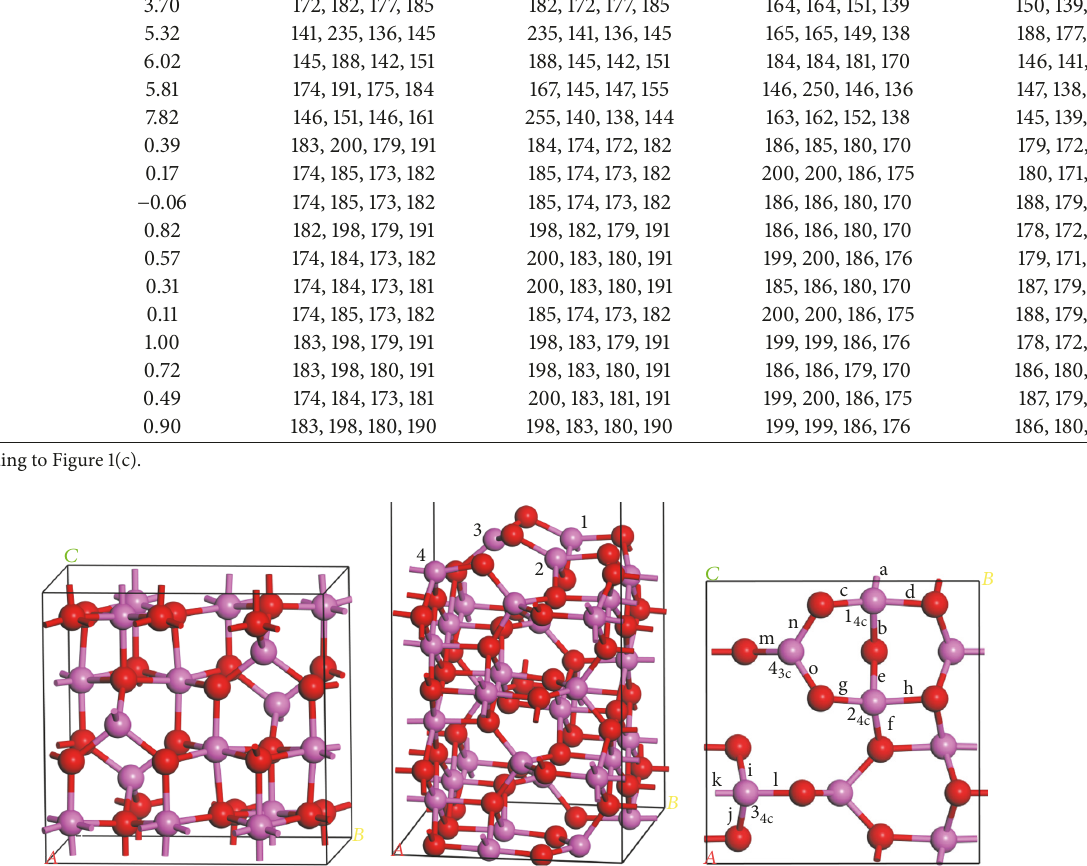
Figure 1: Side view of unit cell of 𝛾 -Al 2 O 3 (a) and side (b) and top (c) views of the 𝛾 -Al 2 O 3 (110) surface (Al and O atoms are in rose and red, respectively. Coordination numbers of surface atoms are shown in subscript in